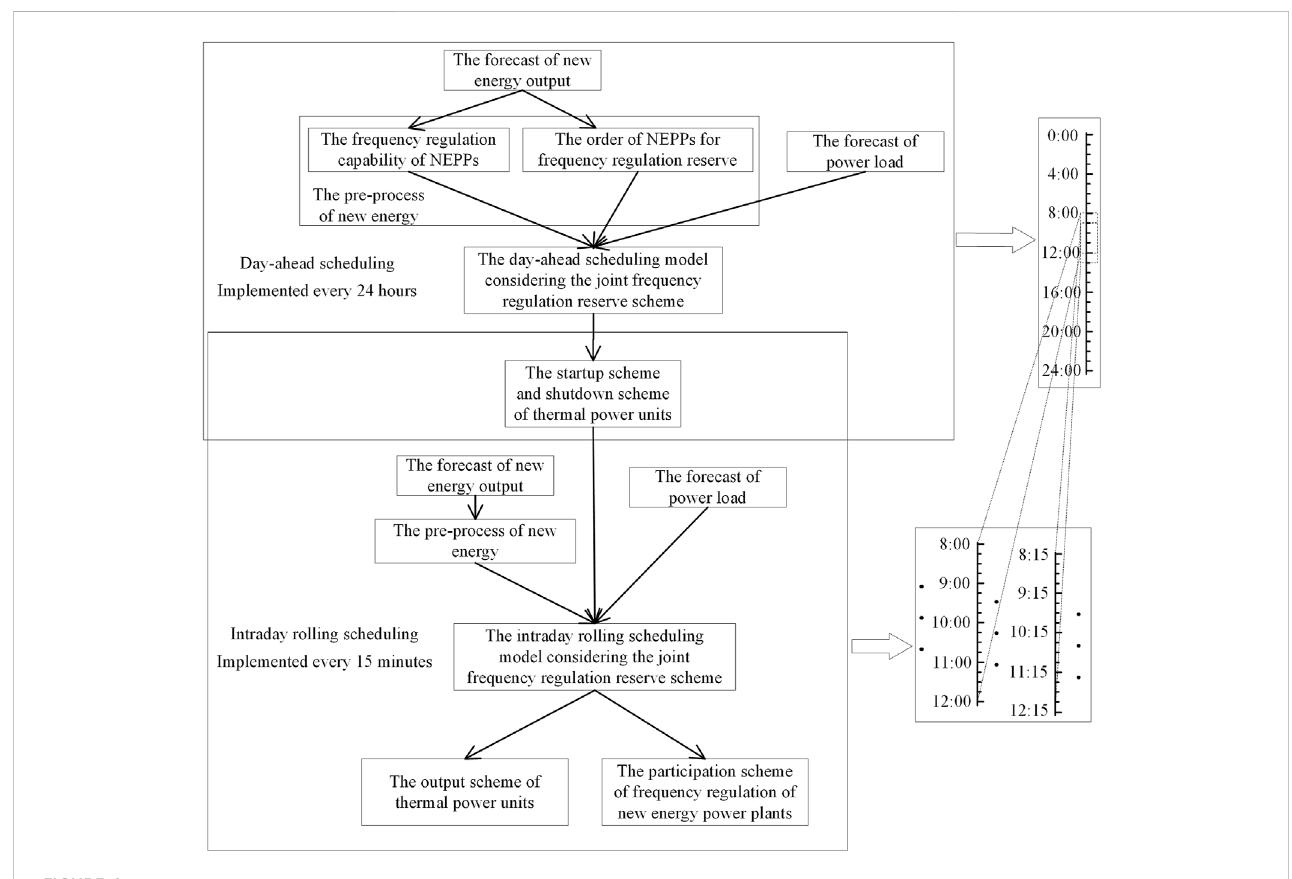
FIGURE 4 Schematic diagram of the scheduling strategy proposed in this